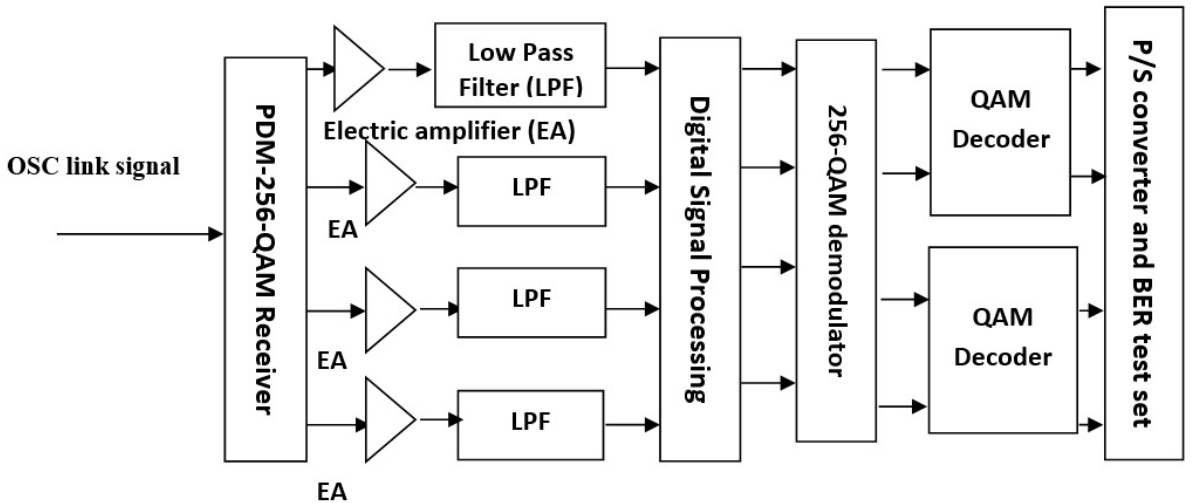
Figure 5. Components of the PDM ‐ 256 ‐ QAM receiver.